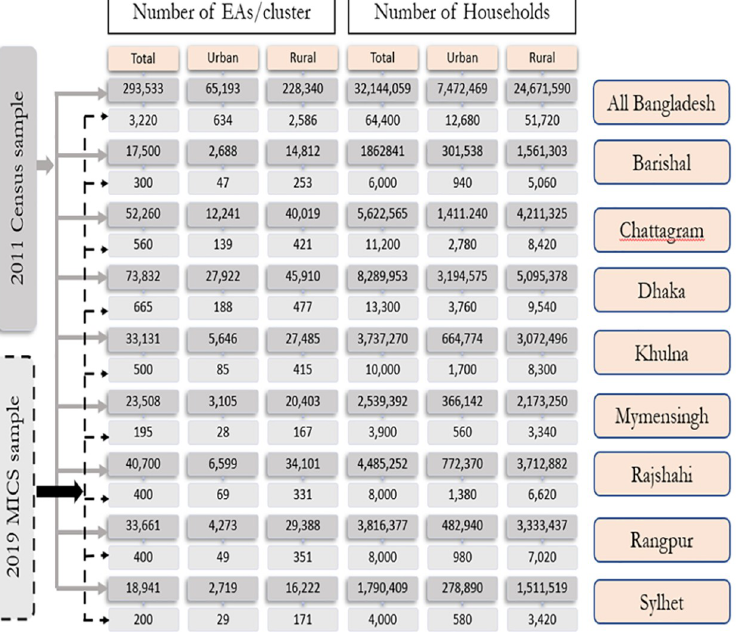
Fig 3. Sample size and sample allocation (Source: